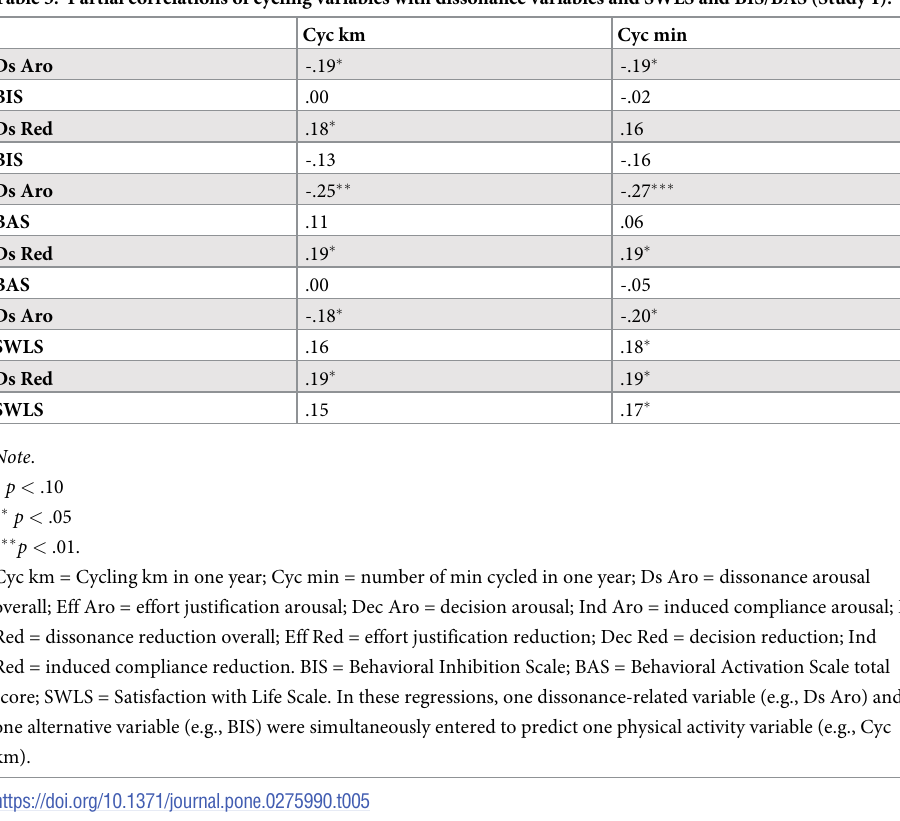
Table 5. Partial correlations of cycling variables with dissonance variables and SWLS and BIS/BAS (Study 1). Cyc km Cyc min Ds Aro -.19 � -.19 � BIS .00 -.02